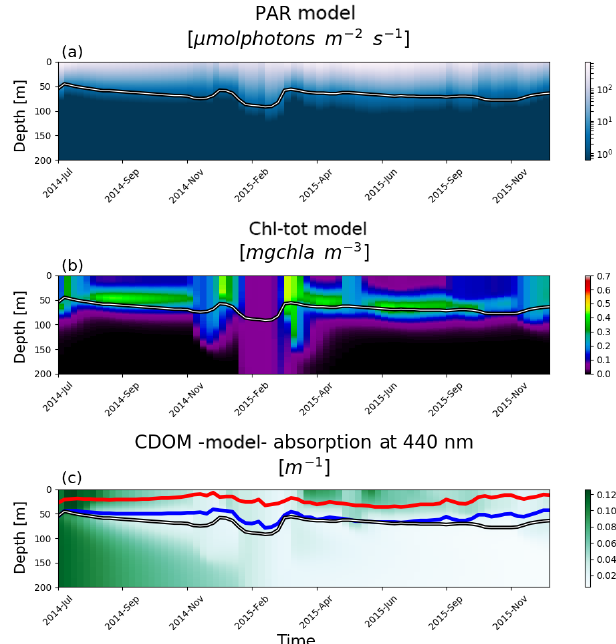
Figure 12. Hovmöller diagrams for BGC-Argo float lovbio068d (WMO code 6901648) deployed in the northwest Mediterranean showing PAR (a) , total Chl (b) , and CDOM (c) simulated by model configuration OPT5. The white, red, and blue lines depict the eu- photic, 100%, and 10% bleaching depths